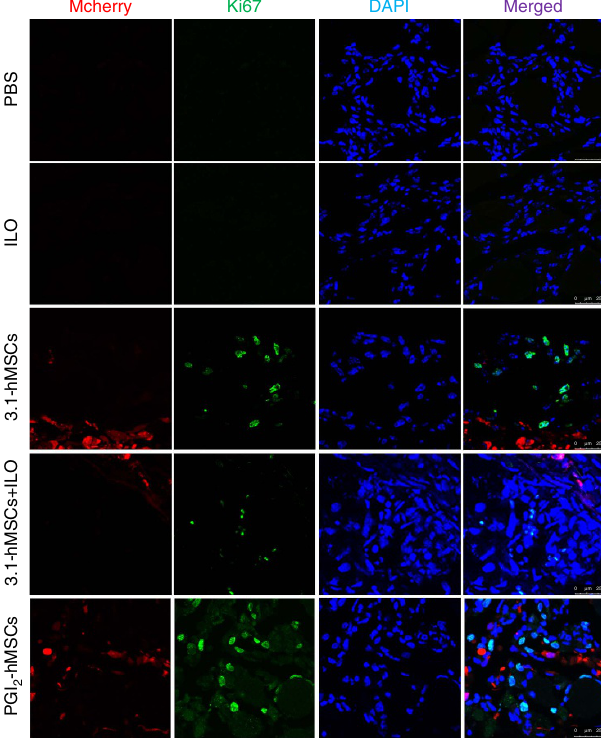
Figure 4 | Human mesenchymal stem cells mediated host cell proliferation. Representative immunofluorescence confocal images illustrate endogenous Ki67 þ cells spread within the hMSC injection area at day 3. Human mesenchymal cells contain red fluorescent mCherry protein. Ki67 þ cells were rarely seen in the gastrocnemius muscles of ischaemic legs of vehicle- and ILO-treated mice. Scale bar, 25 m m.